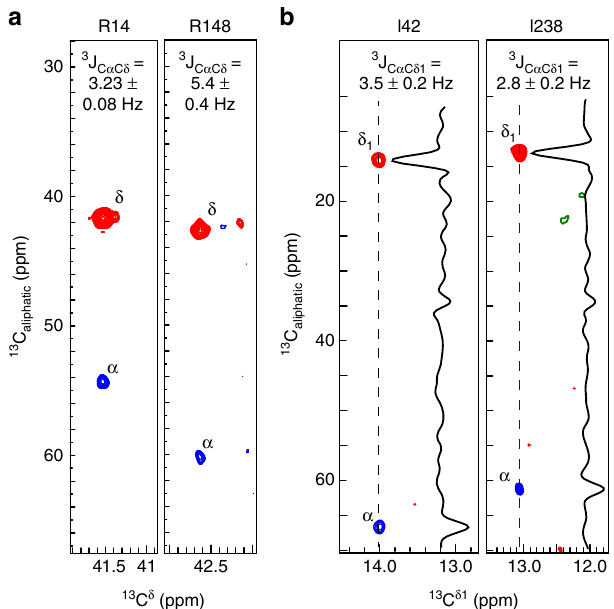
Fig. 5 Quantifying long-range scalar 13 C – 13 C couplings. a Two examples of strips used to quantify long-range 13 C δ – 13 C α scalar couplings in the arginine side chains of T4L L99A at 18.8T and 278K. The R14 side chain is fl exible, while the R148 is rigid in agreement with relaxation measurements 6 . b Strips from a three-dimensional experiment to quantify long-range 13 C δ 1 – 13 C α scalar couplings in isoleucine side chains of the 82-kDa MSG at 14.1T and 310K. The I238 side chain is dynamic around the χ 2 angle, as seen by the intermediate value of the 3 J C α C δ 1 coupling constant, whereas I42 is more rigid in a trans conformation. Positive contours are depicted as red, while negative contours are in blue. Values for 3 J C α C δ 1 in a and b are